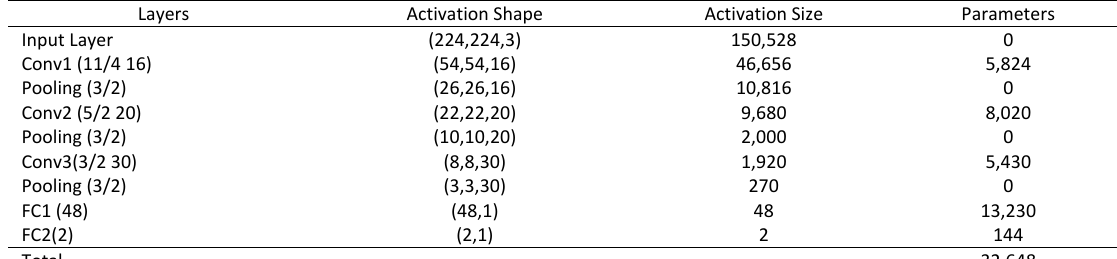
Table 8: The Number of parameters of mAlexnet